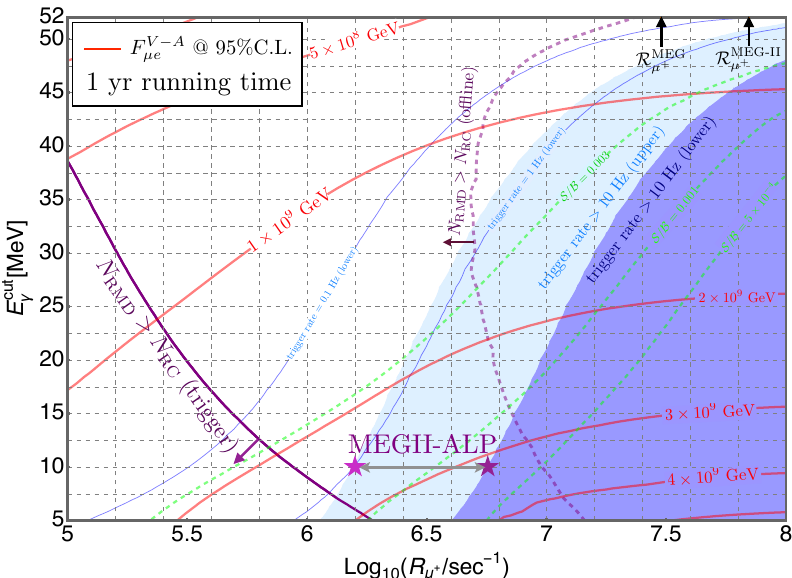
Figure 4 . MEG II-ALP performances as a function of the photon cut E cut intensity R . In red contours of the 95% C.L. reach after enforcing the kinematic selection µ + | m 2 − m 2 | < ∆ and assuming 1 year of running time. The ALP is assumed to be massless m 2 a /E /E within the experimental resolution. The blue lines indicate 0.1 Hz and 1 Hz of the trigger rate, which gets larger than 10 Hz in the shaded regions. The dashed green show contours of S / B . On the right of the solid purple line the RMD background dominates over RC at trigger level, the dashed purple line shows where the RMD dominates with the offline selection. The stars indicates the benchmarks chosen for the MEGII-ALP dedicated run, see eq.